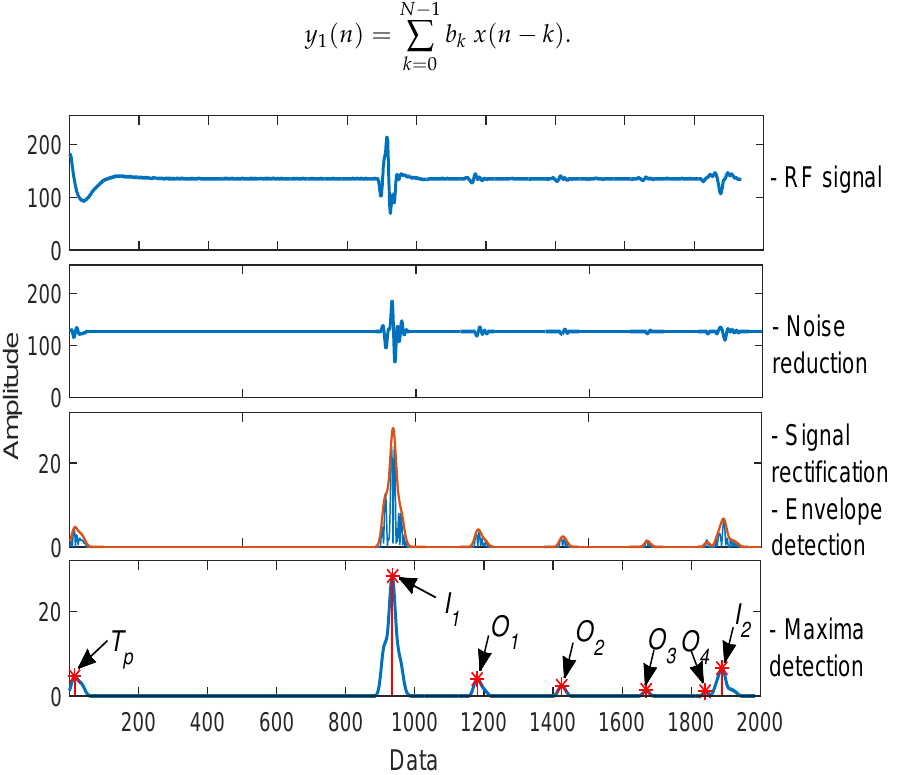
Figure 4. Ultrasound signal processing technique steps: noise reduction, signal rectification, envelope detection, and maxima detection